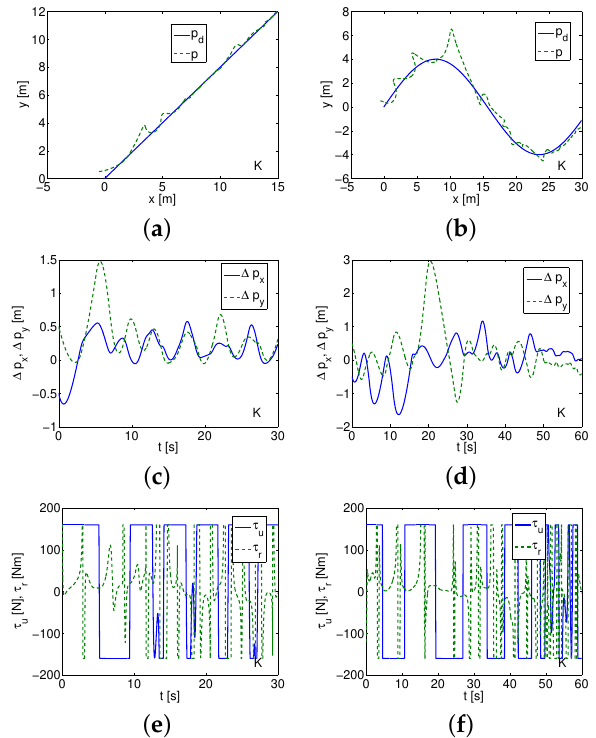
Figure 6. Simulation results for Kambara (SMC)—linear and sine trajectory. ( a , b ) Desired and realized trajectory; ( c , d ) position errors; ( e , f ) applied forces/torques.